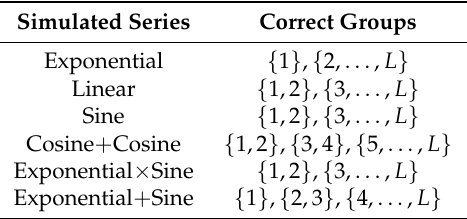
Table 1. Correct groups of the simulated